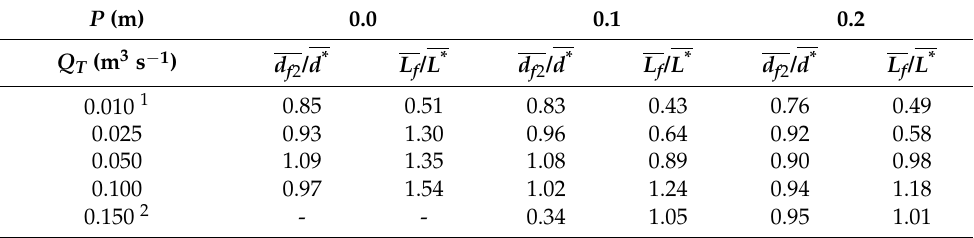
Table 3. Values of the rates between the mean value of d f2 with respect to the mean value of d* (d f 2 / d ∗ ) , and the mean value of L f with respect the mean value of L* (L f / L ∗ ) for every value of